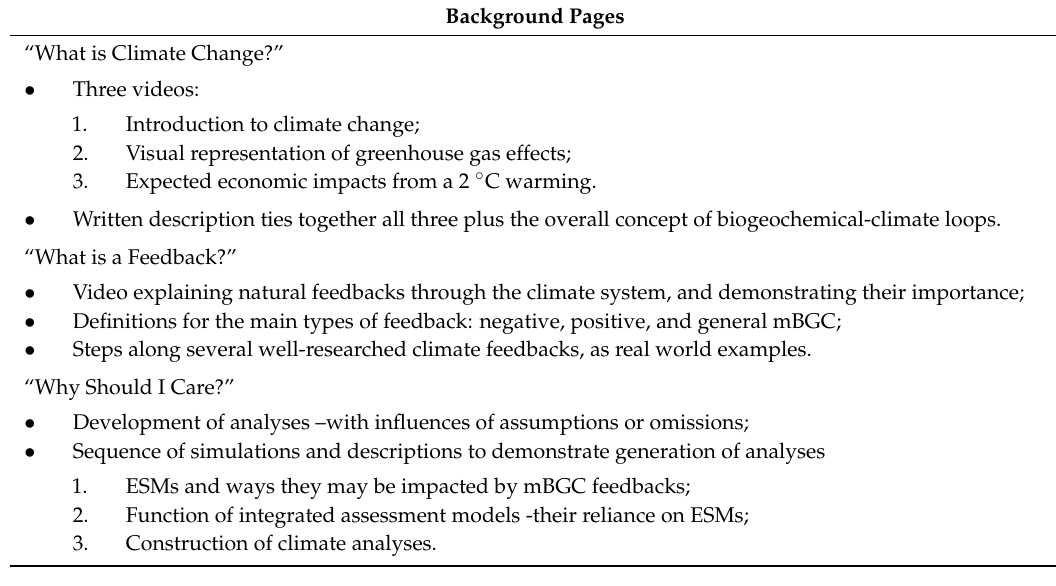
Table 1. List of pages and content included within the background